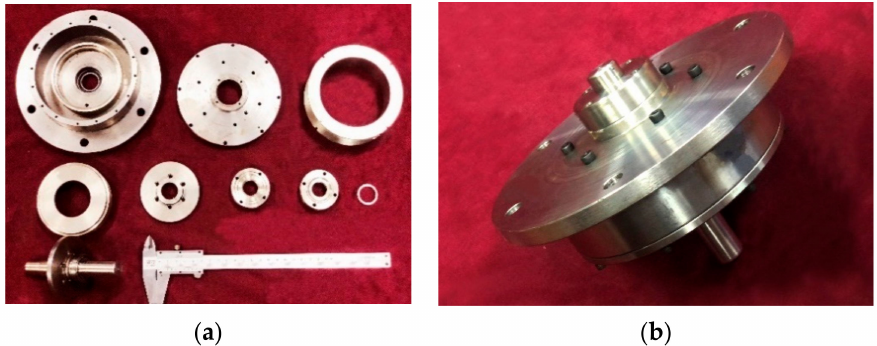
Figure 11. Prototypes of MR brake. ( a ) Components and ( b ) prototype.